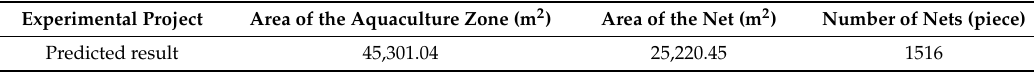
Table 6. Area and quantity extraction